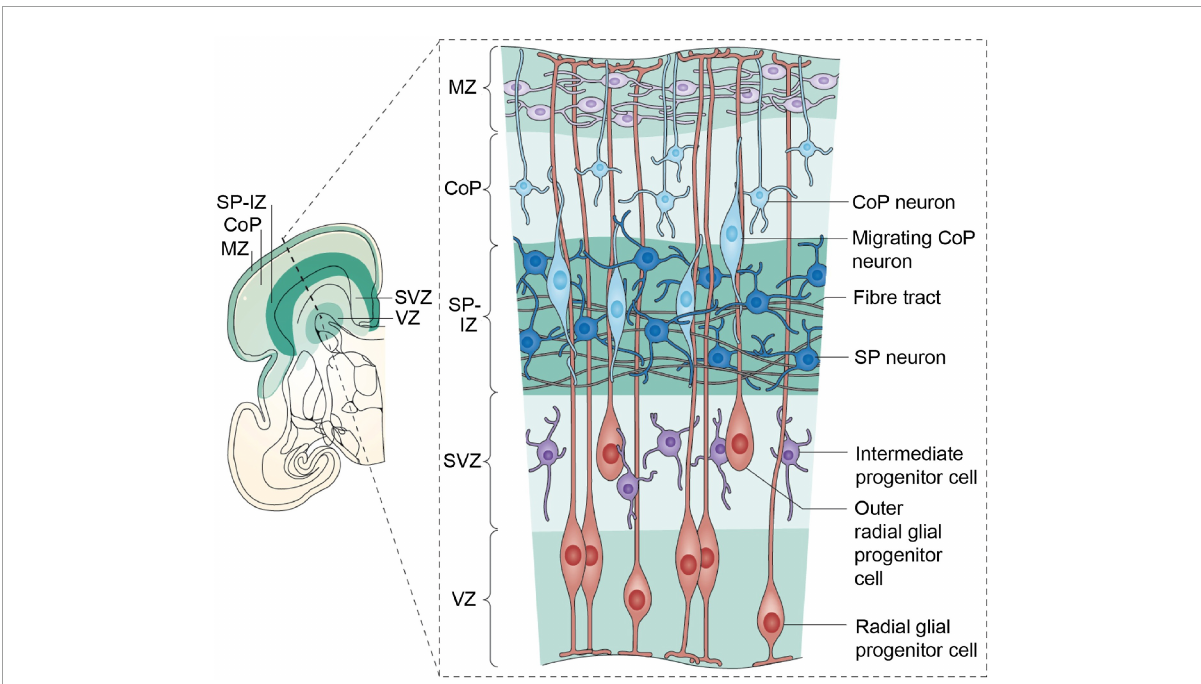
FIGURE5 The human cerebral cortex at 28 weeks postmenstrual age (PMA; 8 weeks before birth). A coronal section is shown on the left; the inset box on the right provides details of the developmental processes. The ventricular zone (VZ) and subventricular zone (SVZ) constitute the germinal matrices where cell division occurs. The first generations of cells are generated in the VZ, the later generations in the SVZ. The SVZ is a structure that expanded during phylogeny; it is especially large in primates. The radial glial cells span their shafts between the germinal layers and the outer layer of the cortex [marginal zone (MZ)]. The first-generation neurons have migrated to the subplate (SP) and participate in the functional fetal cortex; later generations of neurons migrate to the cortical plate (CoP). Figure from Hadders-Algra (2018a), see Luhmann et al. (2018) for